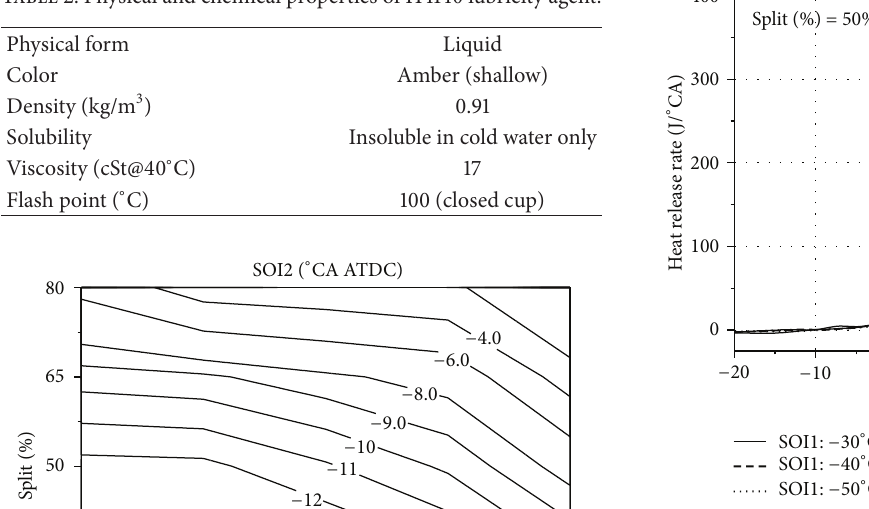
Figure 3: Heat release profile as a function of SOI1; split percentage set at